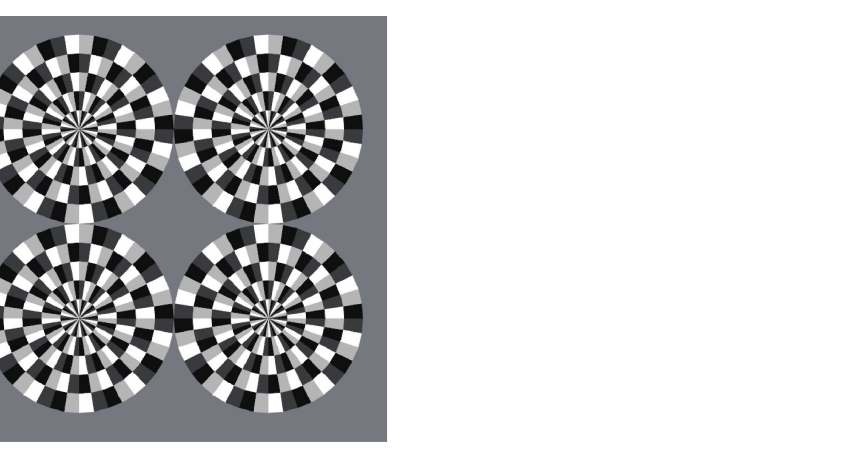
Fig 1. Stimulus patterns that perceive the RSI. This illusion incorporates four gray-scale patterns: black, light gray, white, and dark gray. The direction of motion changes depending on the arrangement of the pattern. Our study repeatedly aligned the patterns to enhance the intensity of the